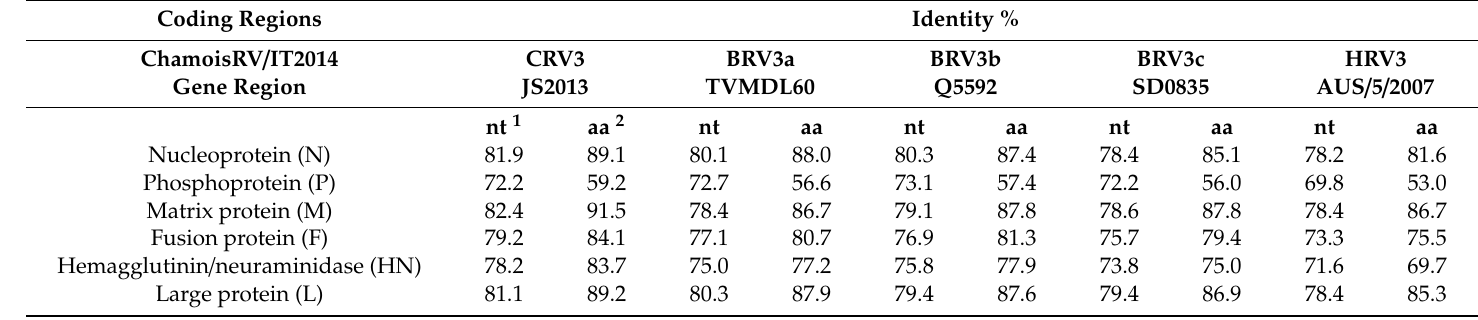
Table 1. Nucleotide and amino acid identities for each gene segment of the novel respirovirus sequence from chamois compared to respirovirus reference strains from GenBank.